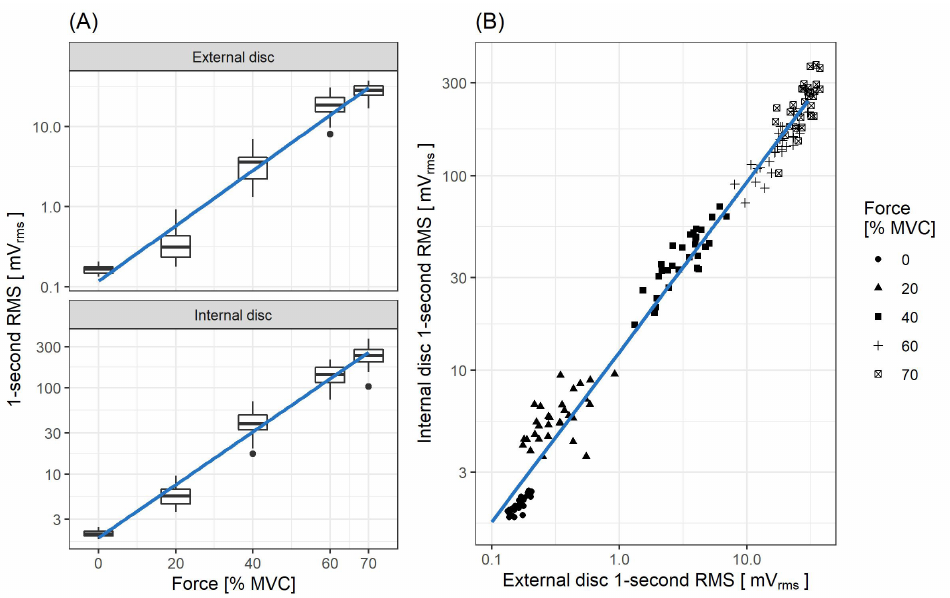
Figure 6. The root mean square (RMS) values of the subsequent 1-second parts (no overlapping) of MMG signals recorded during step isometric measurements. ( A ) RMS values for both of the sensor discs are plotted against the percentage of maximum voluntary contraction (MVC). The regression lines are fitted with log-transformed values of RMS. ( B ) RMS values of both signals are compared and a linear regression model in the log–log space is